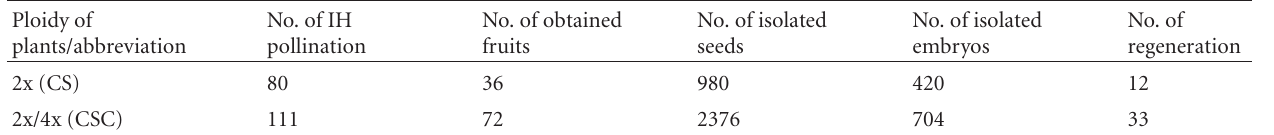
Table 3: Summary of cross in vivo pollination C. sativus (2x; 2x/4x) × Cucumis